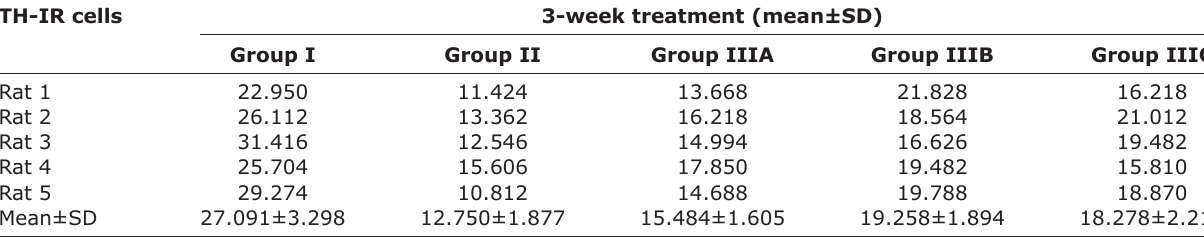
Table-1: Average total number of TH-IR cells in the SNpc of five groups. TH-IR